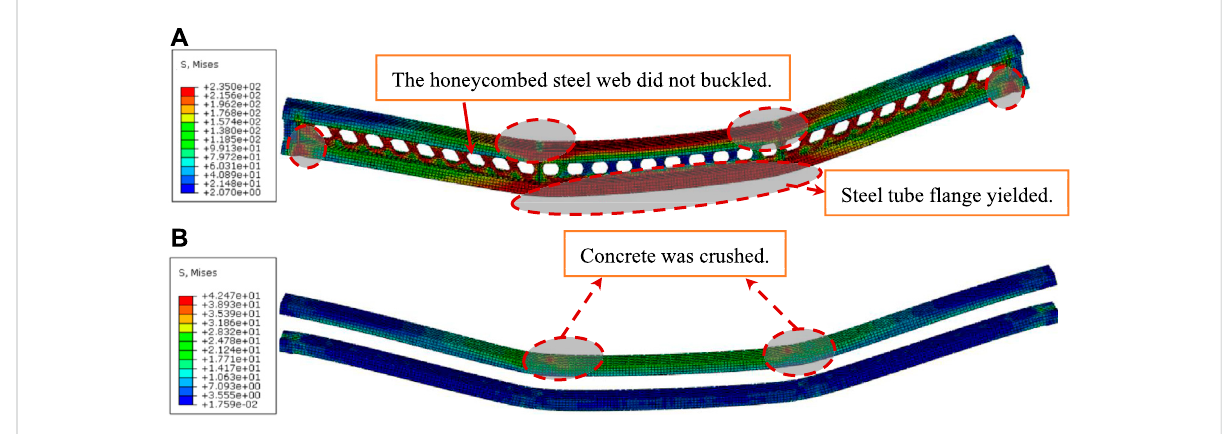
FIGURE 13 The stress cloud of SHC. (A) The stress cloud of steel tube fl ange of SHC2 (B) The stress cloud of concrete of